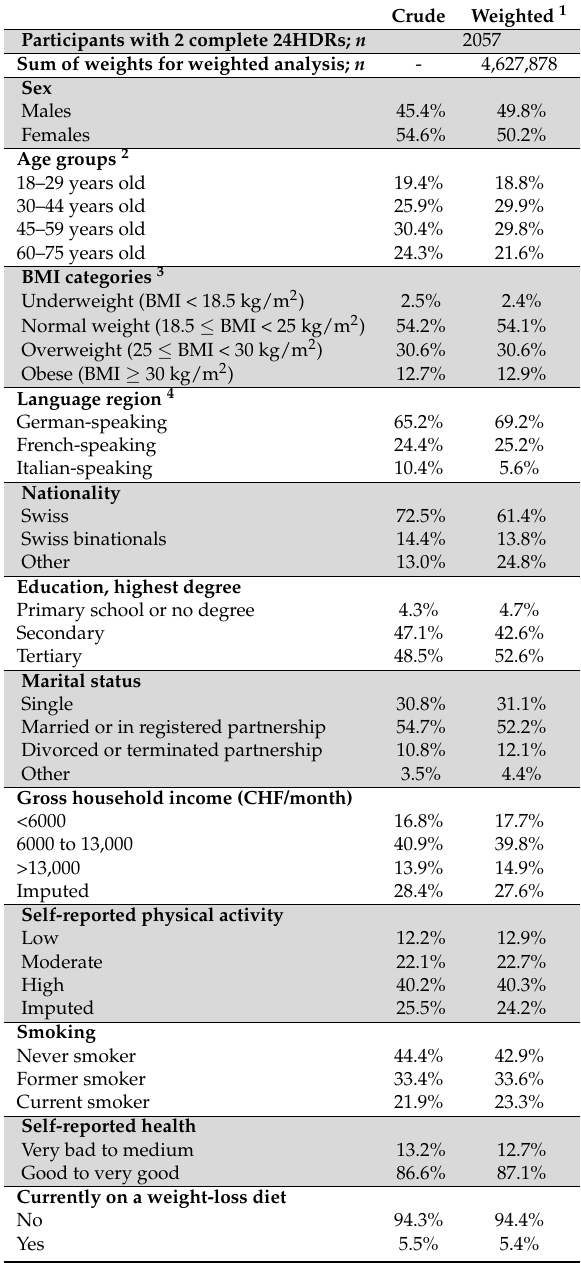
Table 1. Characteristics of the study